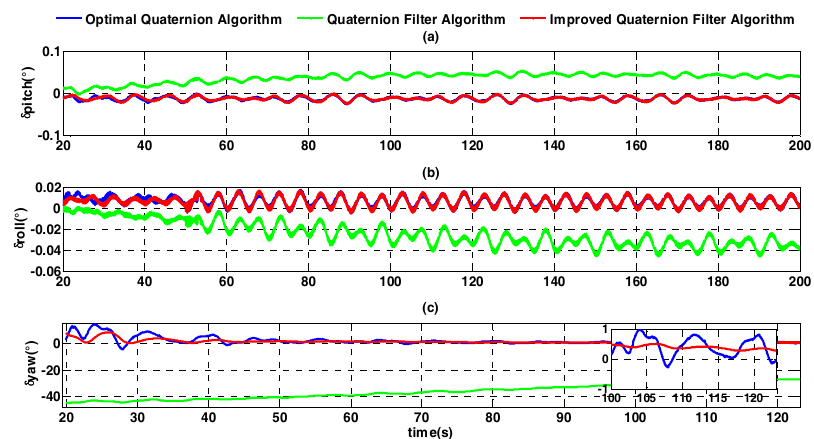
Figure 7. Attitude error curves of coarse alignment (the swing center of heading is 45°). ( a ) The error curves of pitch angle; ( b ) the error curves of roll angle; ( c ) the error curves of heading angle.